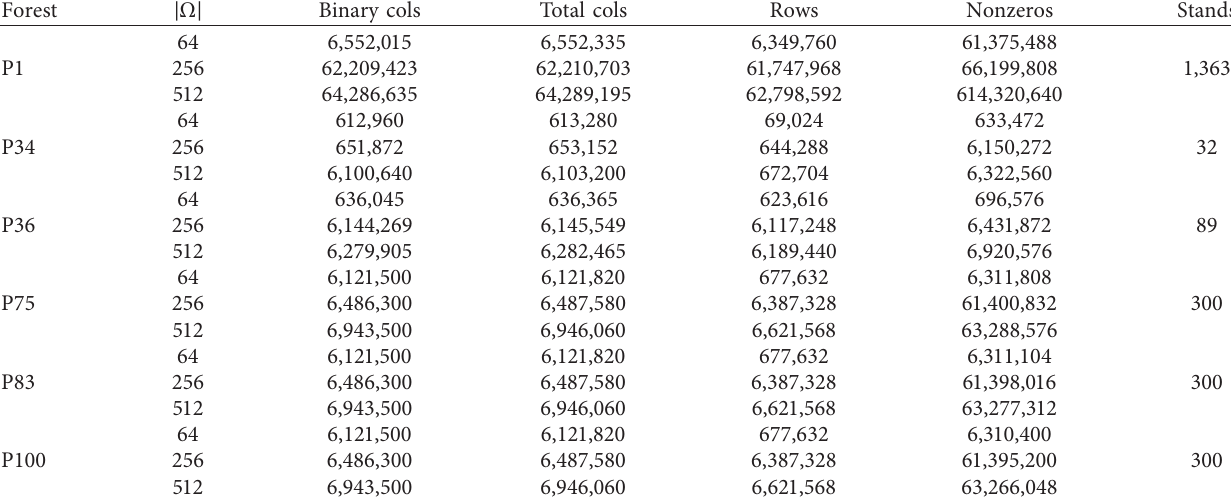
Table 3: Description of problem